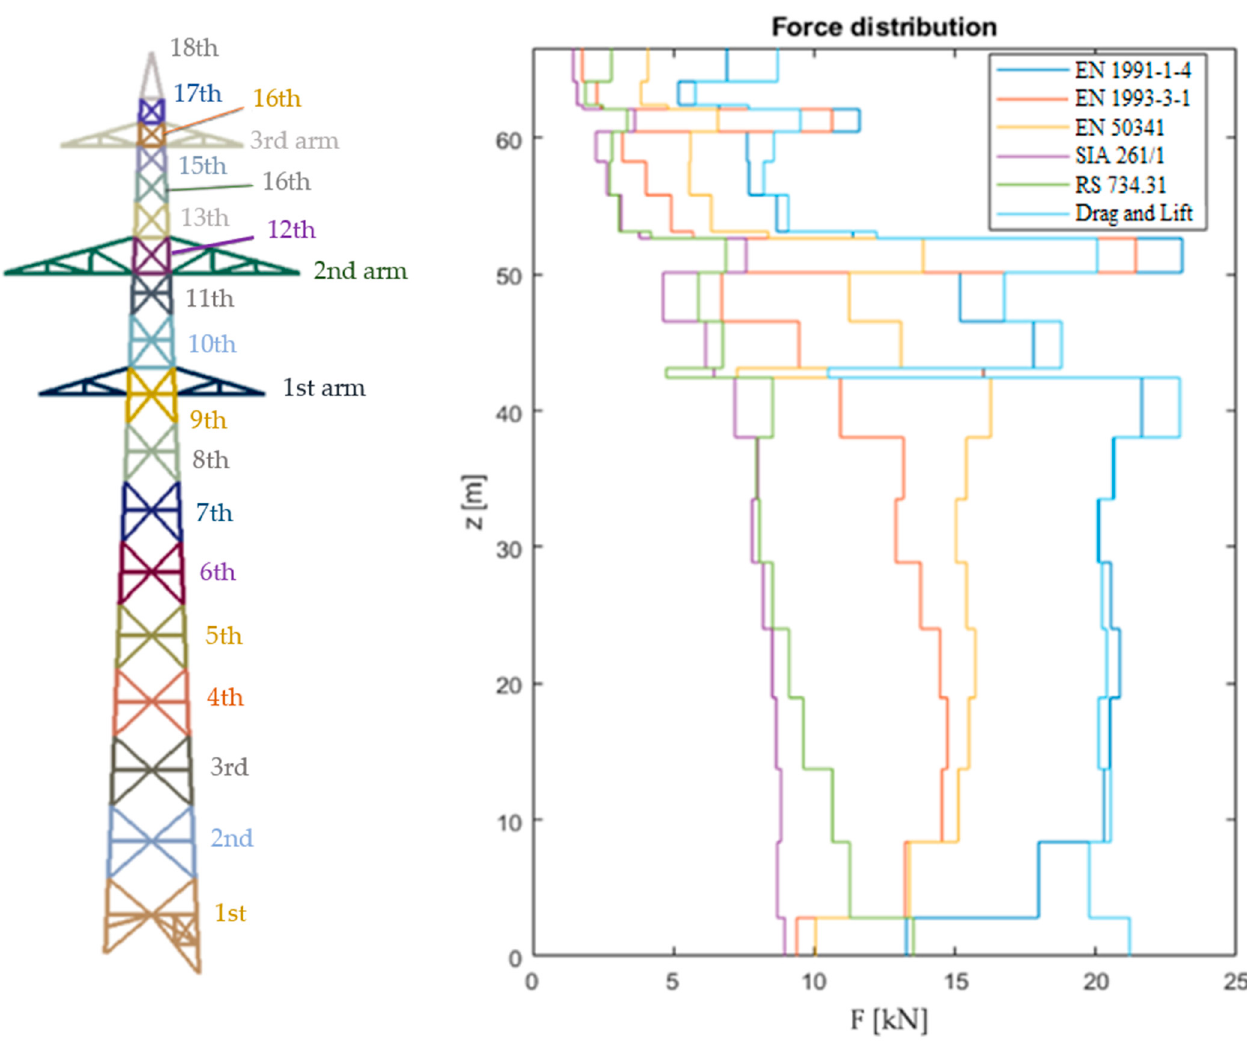
Figure 19. Total forces on each of the sections with purely transverse wind (0°).